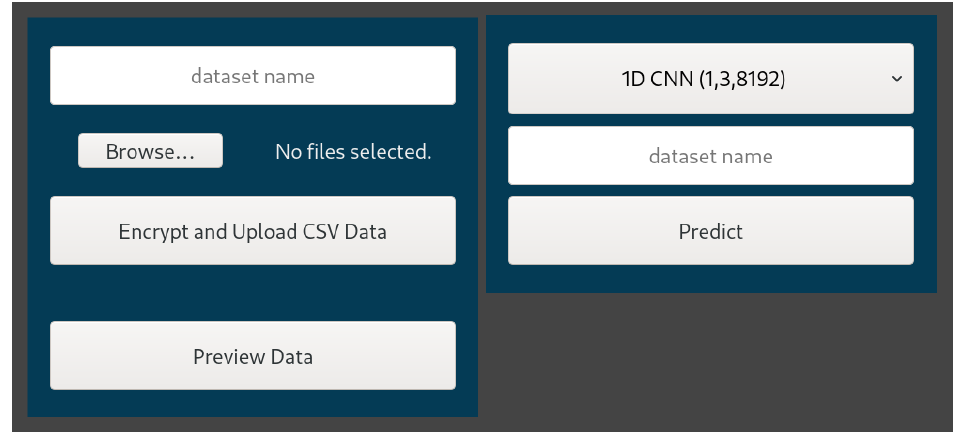
Figure 3. FHE dashboard, allowing simple upload, data view (of metadata since data is encrypted), and processing of